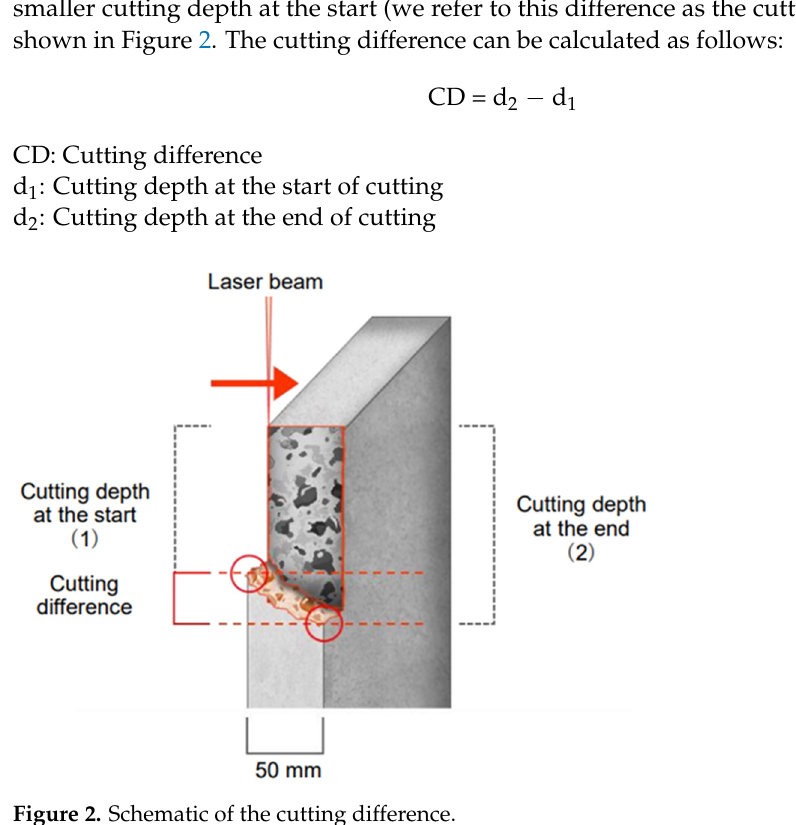
Figure 2. Schematic of the cutting difference.